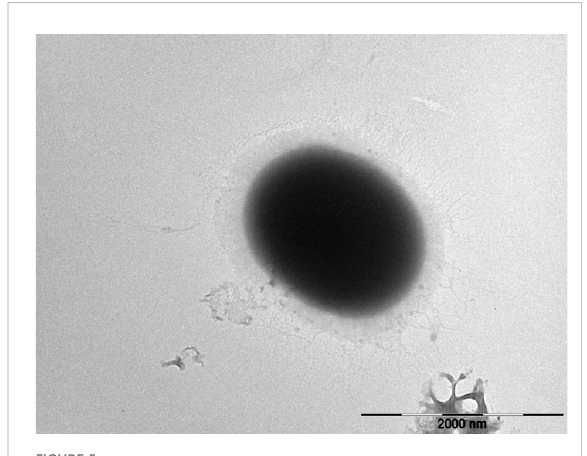
FIGURE 5 Representative images of (A) the untreated E. faecium 1449 cell (scale bar = 2000 nm).